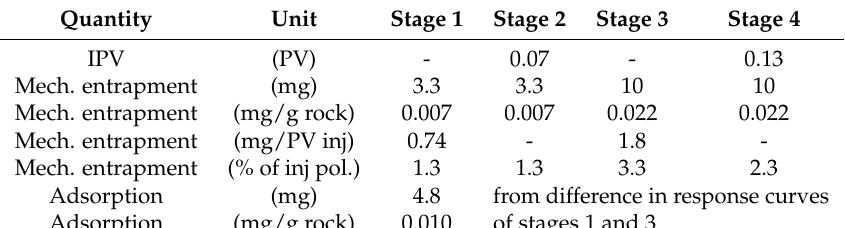
Table 8. IPV, adsorption, and mechanical entrapment of polymer during Experiment 2.